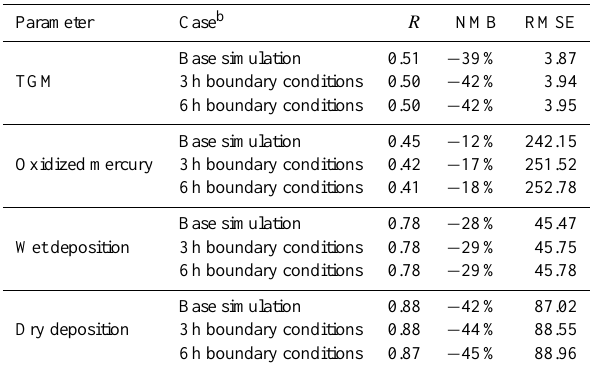
Figure 11. Taylor diagram of simulated annual TGM, Hg(II) + Hg(P), dry deposition, wet deposition and precipita- tion over East Asia in the global and nested domains (denoted as 1 and 2). Table 4. Statistical comparisons of the online and offline nested simulation results with observations over East Asia a .